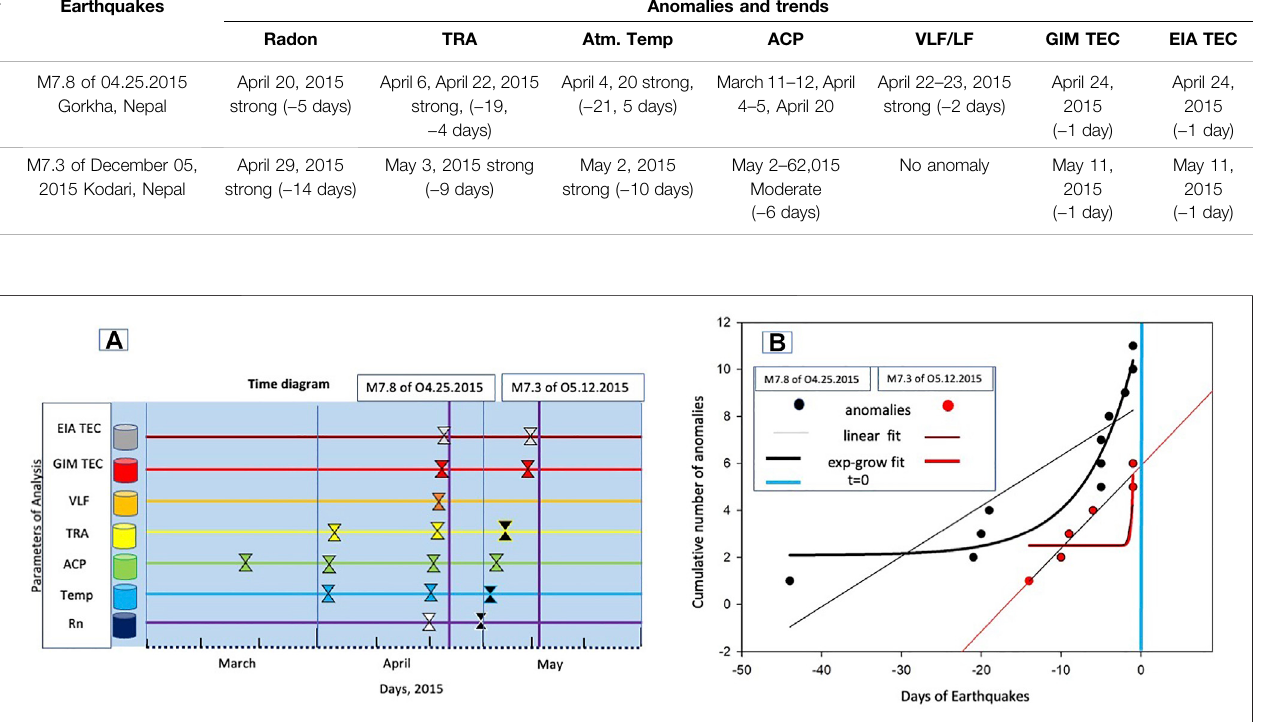
FIGURE13|(A) Fimediagramofmultiparameterprecursorsanalysisplottedwithdatashownin Table1 .Thelistofanalyzedparameters (bottom-up) :Rn(Radon gas); Temp (Meteorological Atmospheric temperature); ACP (Atmospheric chemical potential); TRA (Thermal Radiation Anomaly); VLF (Vert low Frequency); GIM TEC (Global Ionospheric Model, Total Electronic Contents); EIA TEC (Equatorial Ionospheric Anomaly, Total Electronic Contents); (B) Cumulative number of all revealed precursoryanomaliesshownonPanel13a(indicatedhereasblackcirclesandlinesassociatedwithM7.8ofApril25,2015,andwithredcirclesandlinesforM7.3of May 12, 2015, as well.); Time origin t (cid:1) O is the mainshock occurrence (blue line). With Red/Black, thick line curves show the exp-grow fi t while Red/black is the straight line (thin lines). This graph con fi rms strong acceleration as the mainshocks approach both